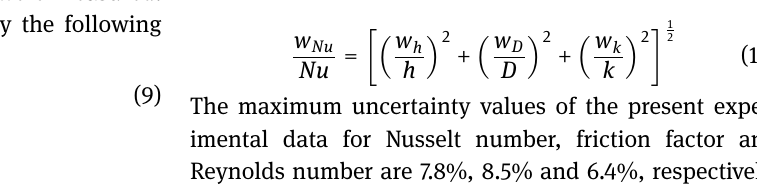
Figure 3: Data verification of mean Nusselt number and friction coeflcient for the plain